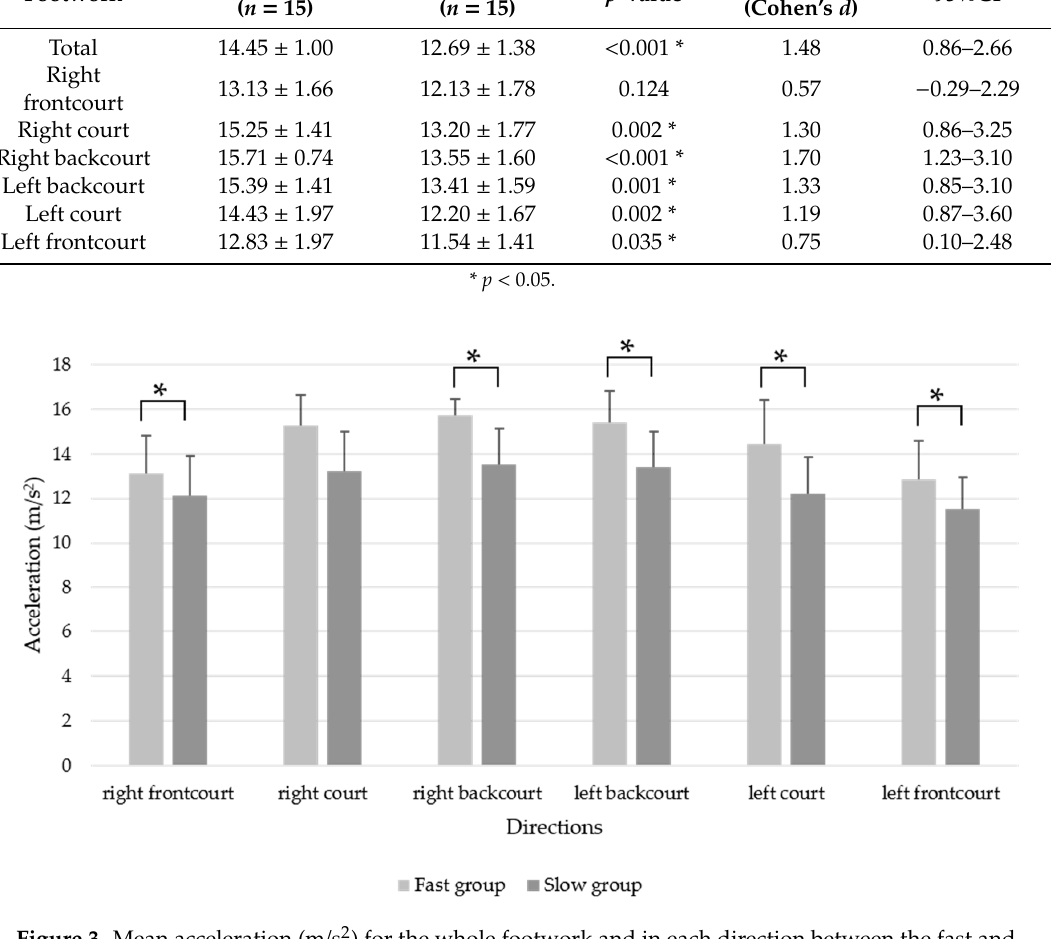
Figure 3. Mean acceleration (m / s 2 ) for the whole footwork and in each direction between the fast and slow groups. * p < 0.05.